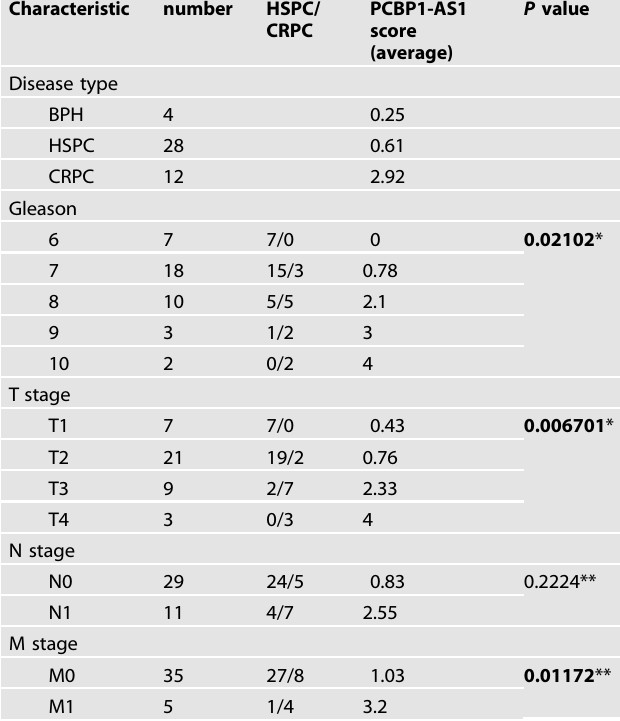
Table 1. PCBP1-AS1 clinical signi fi cance in TMA.